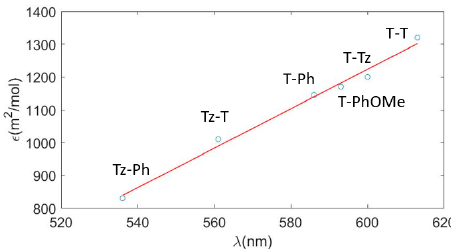
Figure 4. Plot of the maximum values of the molar extinction coefficient of the colored forms in the visible region vs. their spectral positions.